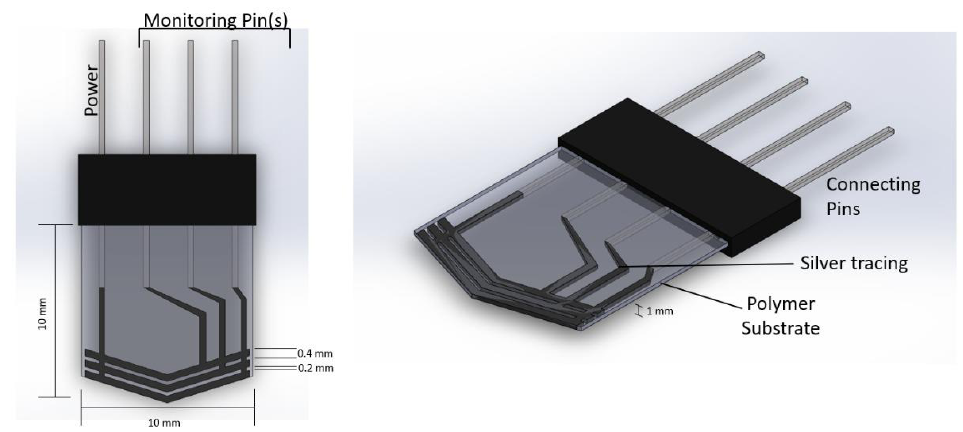
Figure 1. Sensor design and its dimensions.